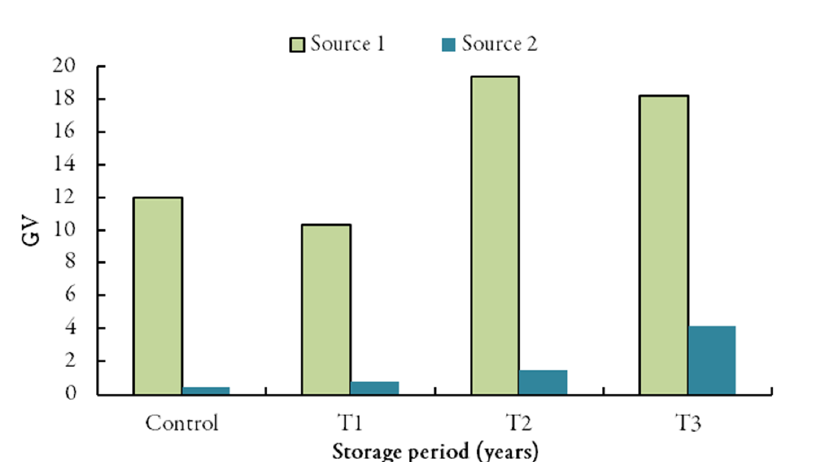
Figure 4. Germination Value (GV) of Pyrus pashia seeds from Source 1 (Champawat) and Source 2 (Pithoragarh) in cold storage (5 °C) after T1- 1 year storage, T2- 2 years storage and T3- 3 years storage duration